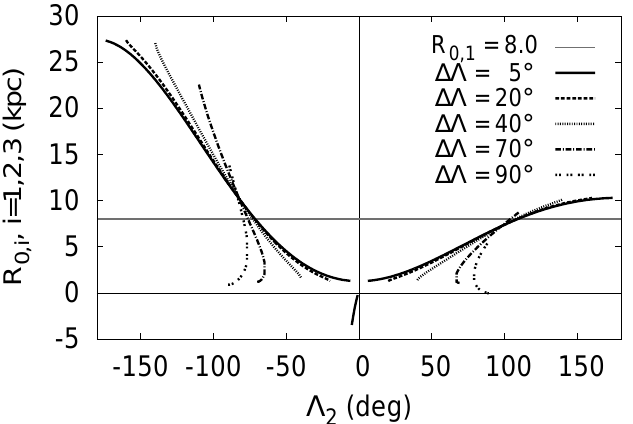
Fig. 2. Dependence of the roots of Equation (5) on the longitude of the point M 2 . Here ∆Λ is the galactocentric angle between the adjacent points in a triplet. The gray horizontal line shows the root that is equal to the initial R 0 value, R 0 , 1 = 8 kpc. The curved lines show the branches of (one or two) additional roots for each ∆Λ (see text). if (Λ 3 − Λ 1 ) (cid:38) 100 ◦ and | Λ 2 | (cid:47) (Λ 3 − Λ 1 ) / 2 (see Fig. 2). Note that, since